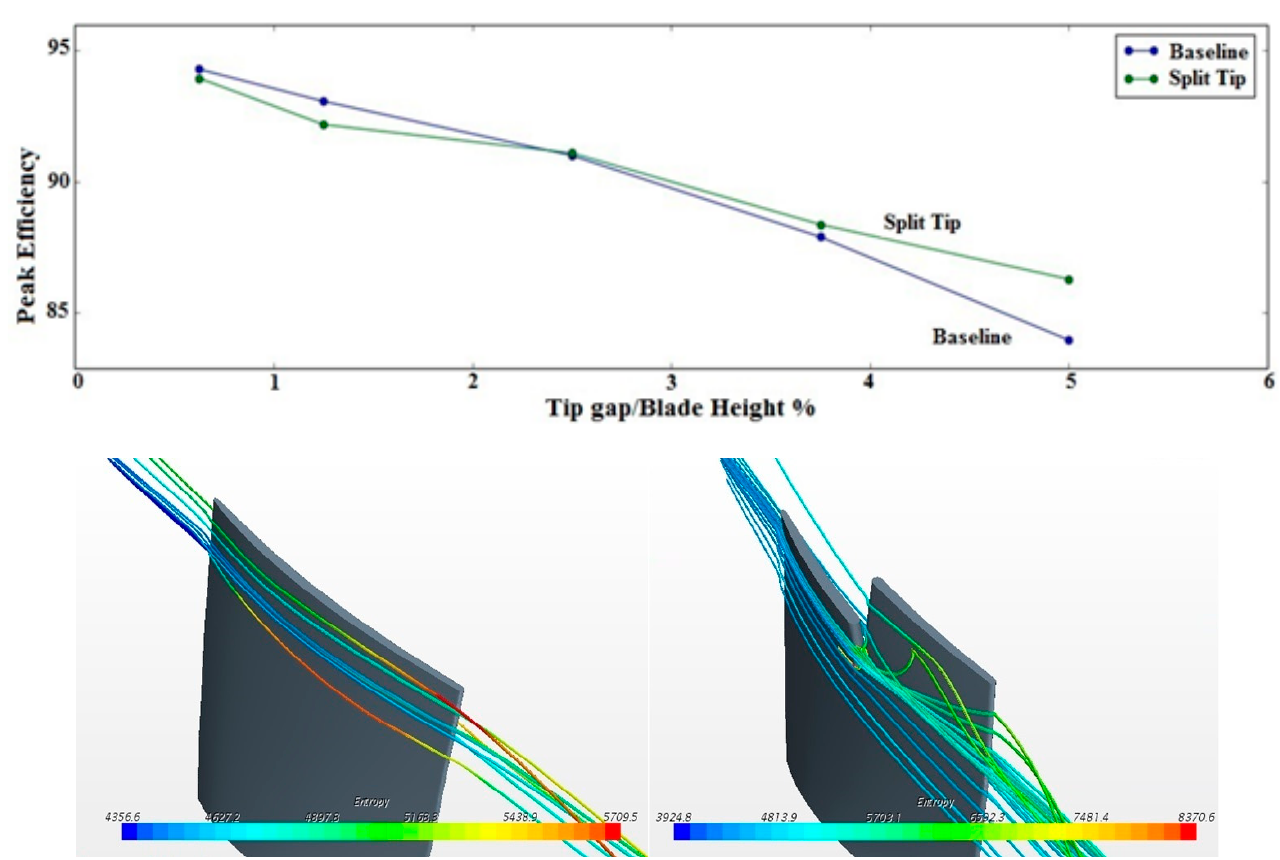
Figure 22. Streamtubes of entropy for baseline and split tip case.